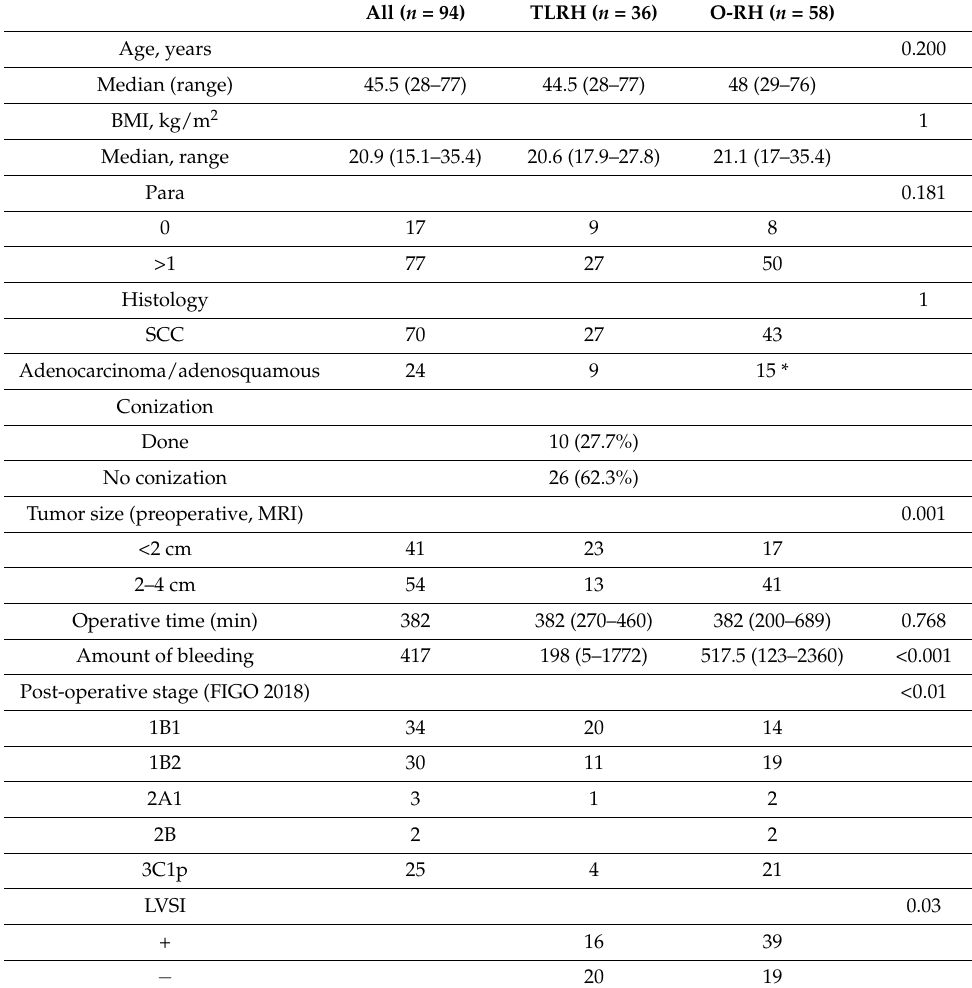
Table 1. The background characteristics of stage 1B1-2 cervical cancer patients who underwent TLRH and